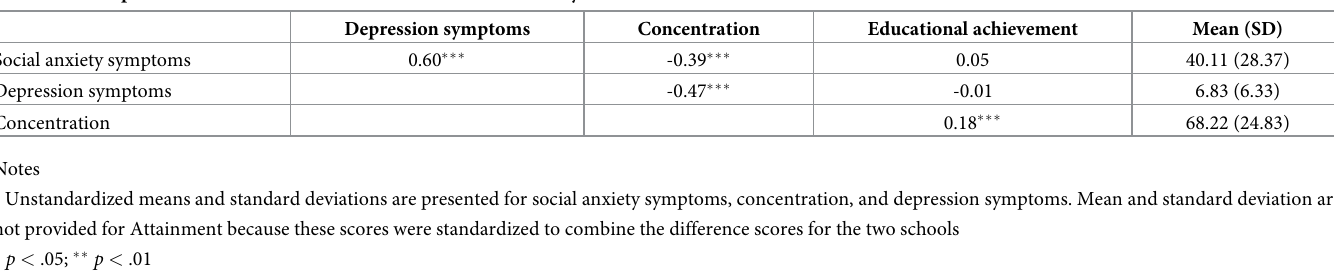
Table 1. Descriptive statistics and Pearson’s correlations of main study variables ‡.